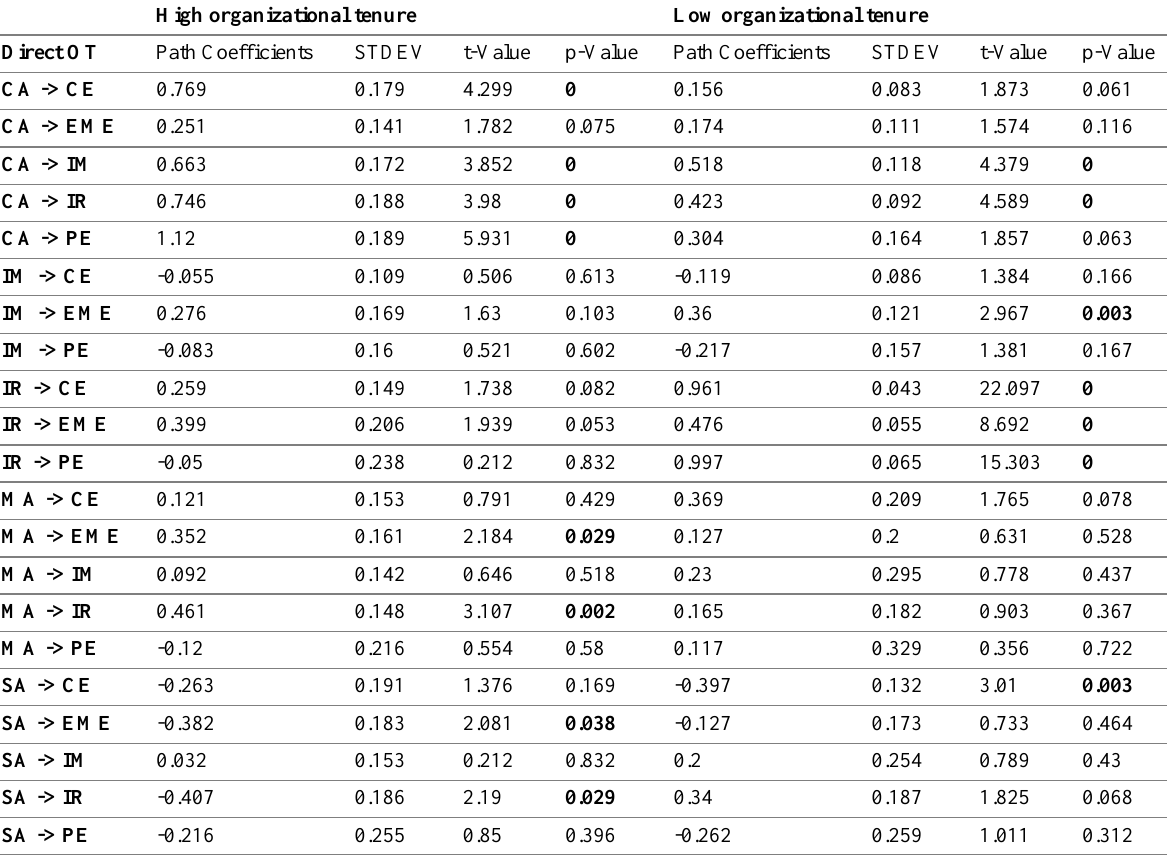
Table 11: Multi-group analysis for organizational tenure (direct effects). High organizational tenure